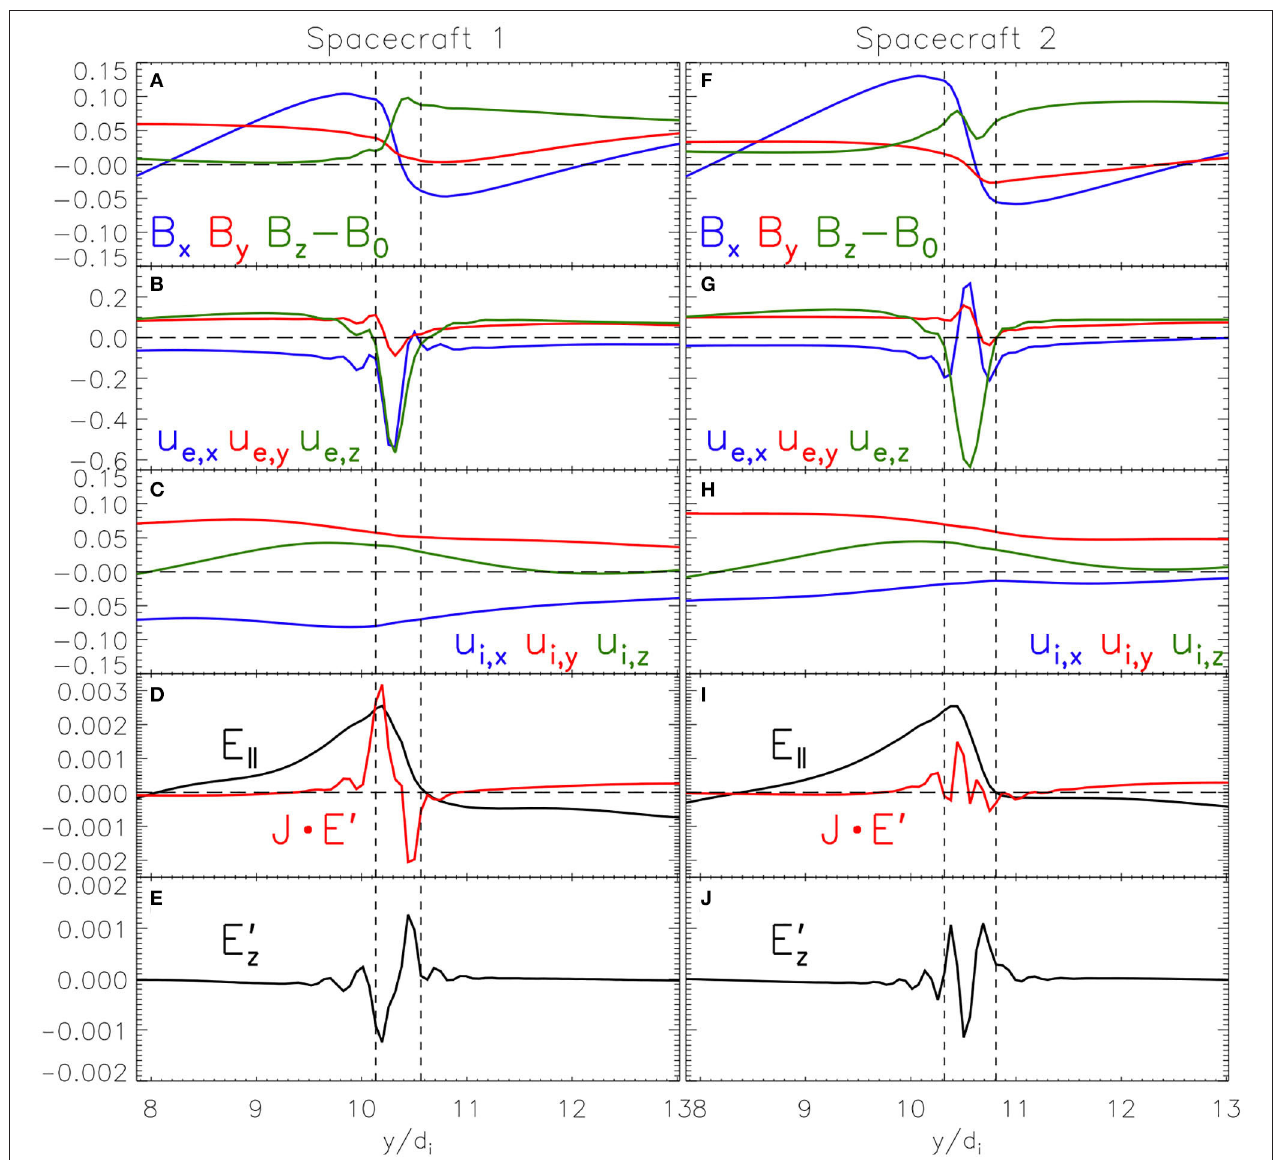
FIGURE 3 | (A–J) Display different physical quantities along the trajectories of virtual satellites dubbed as spacecraft 1 and 2, respectively. From sim.A. Data taken by two virtual spacecraft passing through CS1 along the paths traced by the vertical dashed lines in Figure 2 (“Spacecraft 1” at x 2” at x 58.4 d i , right column). The vertical dashed lines represent the local boundaries of the CS given by the condition ≃